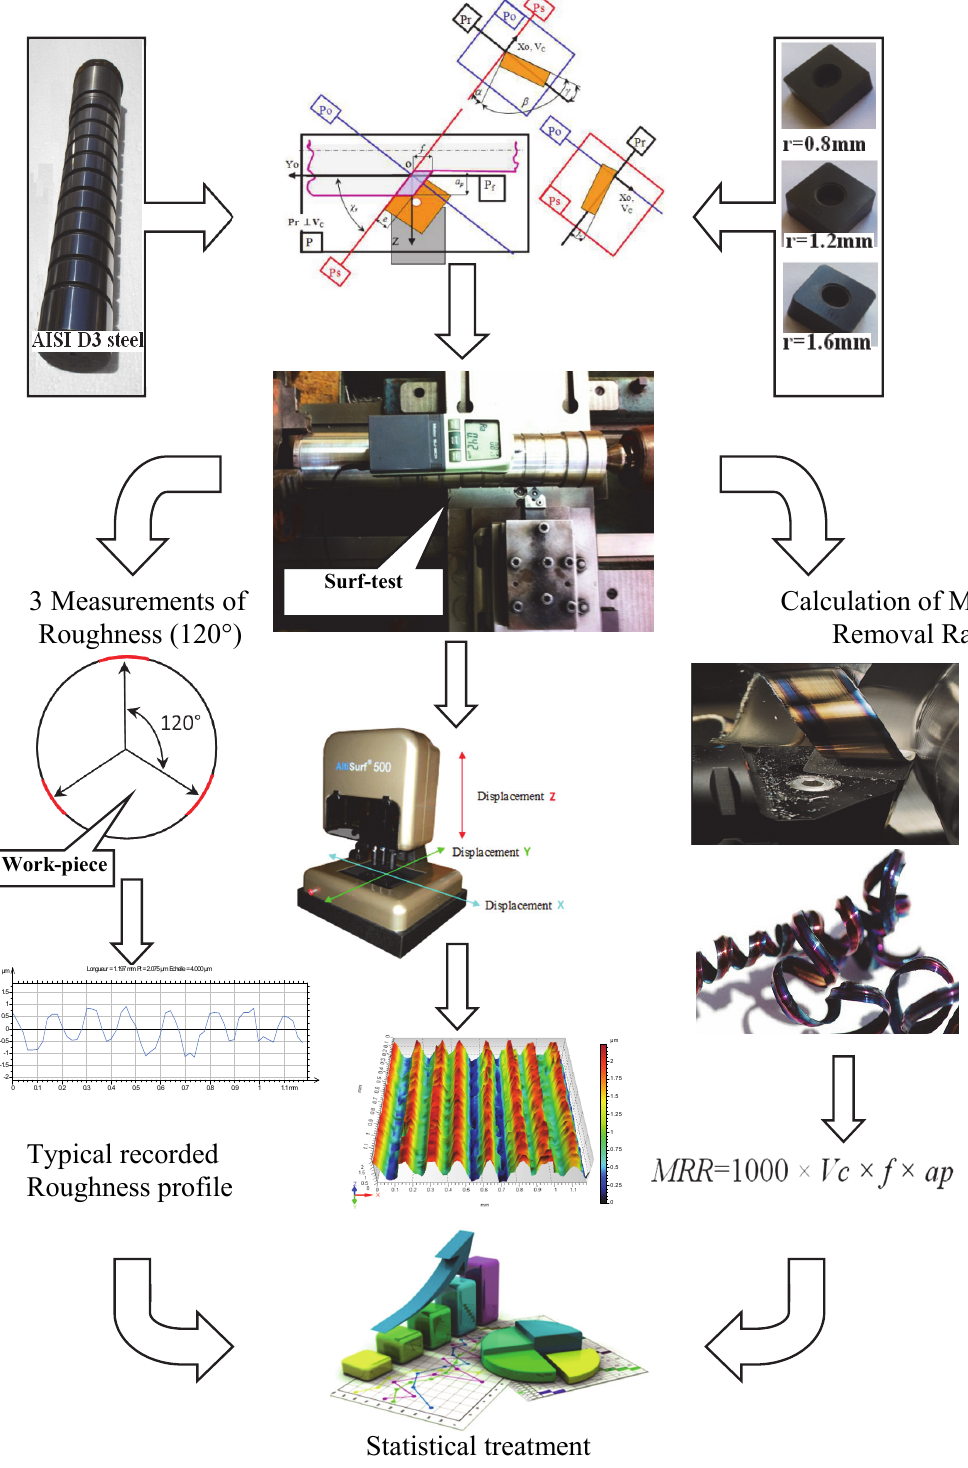
Fig. 2. Schematic diagram of the experimental